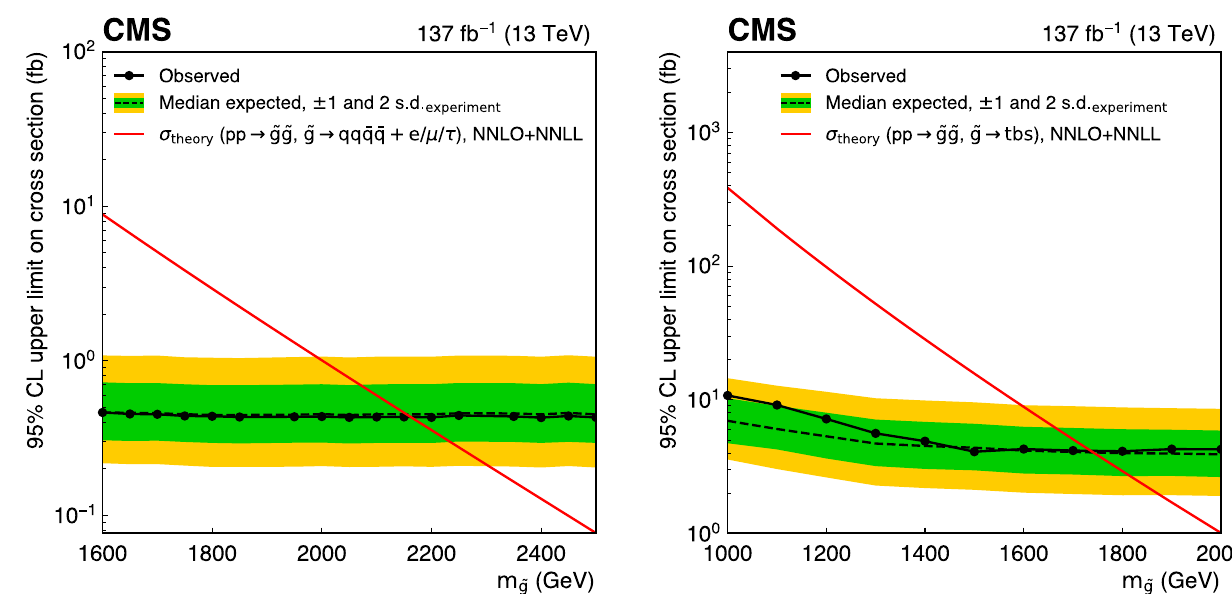
Fig. 12 Upper limits at 95% CL on the cross section for RPV gluino pair production with each gluino decaying into four quarks and one lepton (T1qqqqL, left), and each gluino decaying into a top, bottom, and strange quarks (T1tbs, right)